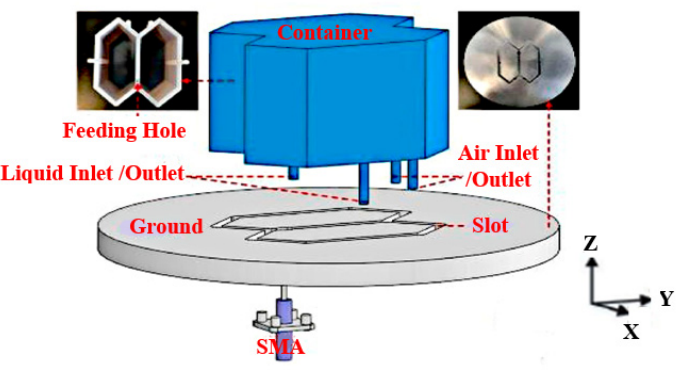
Figure 6. Proposed CP reconfigurable LDRA